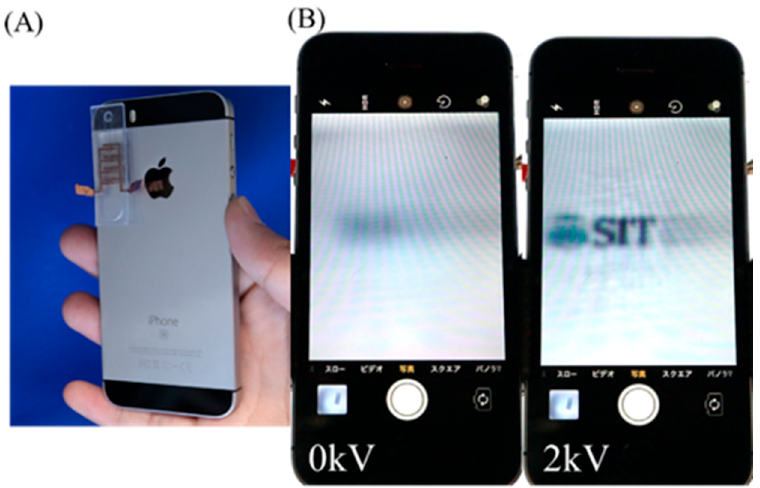
Figure 9. EHD lens demonstration with a smartphone. ( A ) EHD lens attached to the camera part of smartphone. ( B ) A smartphone screen through an EHD lens when voltage is a smartphone. ( B ) A smartphone screen through an EHD lens when voltage is applied.